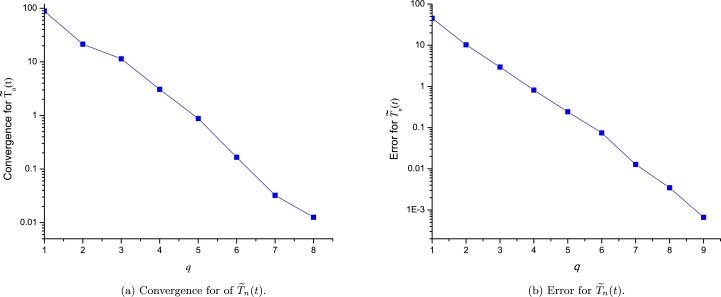
Convergence and error analysis for T˜n(t).